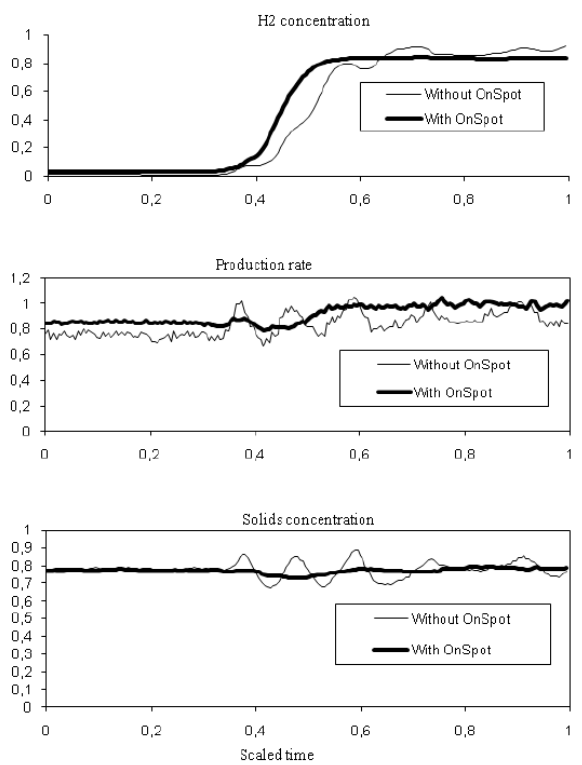
Figure 5: Results from a critical transition in a real plant before (thin lines) and after (thick lines) installation of OnSpot. Scaled vari- ables are shown , with hydrogen concentra- tion (top), production rate (middle), and solids concentration